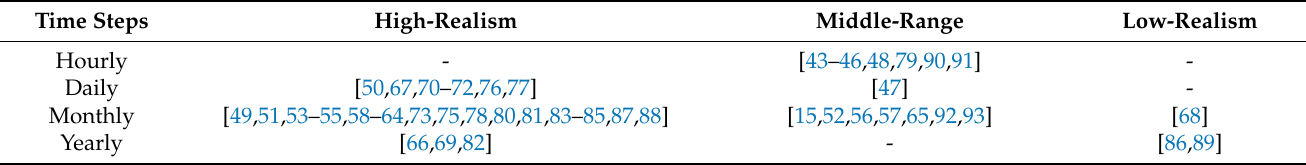
Table 6. Time steps and degree of realism used in the surveyed